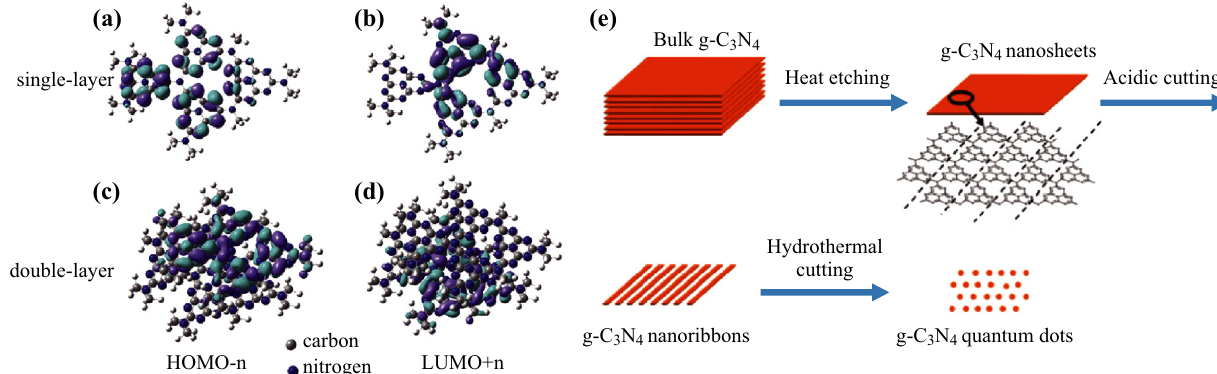
Fig. 7 a HOMO-n and b LUMO ? n orbitals of the single-layered g-C 3 N 4 , respectively. c HOMO-n and d LUMO ? n orbitals of the double- layered g-C 3 N 4 , respectively. Reproduced from Ref. [87] by permission of John Wiley & Sons Ltd. e Schematic illustration of the controllable synthesis of